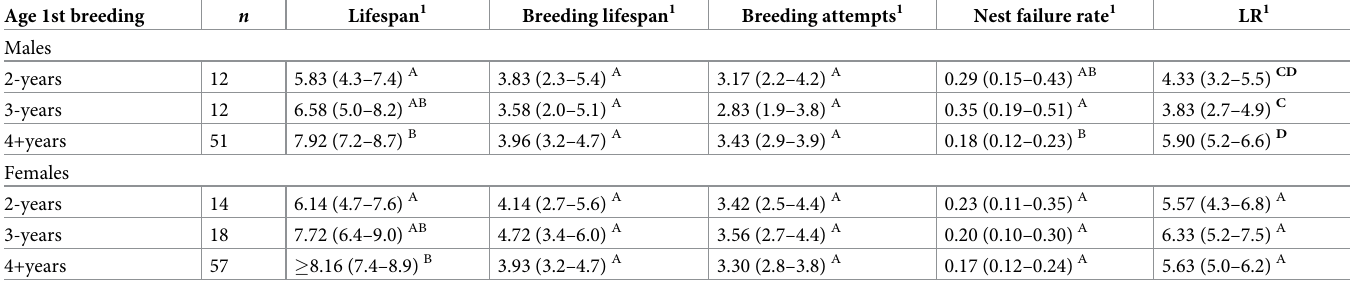
Table 4. Life history characteristics of goshawks first breeding at ages 2-, 3-, and 4+-year-olds. Tukey multiple comparisons of mean ( ± 95% CI) lifespans (years), breeding lifespans (years), number of breeding attempts, nest failure rates, and lifetime reproduction (LR) for 164 first breeding at ages 2-, 3-, and 4+-year-olds (4-year and older known-age + � 4-years-old) goshawks in the 1992–2000 cohorts in Arizona,